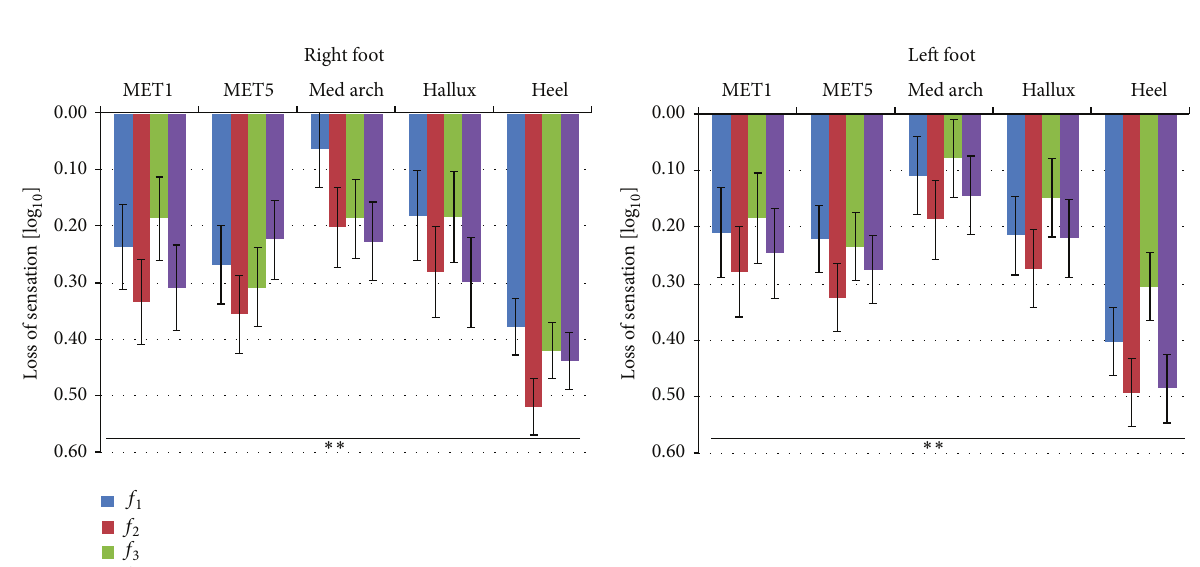
Figure 2: Loss of sensation (LOS) and standard error ( ± SE) in touch-pressure sensitivity with respect to the control condition, for both feet, five regions (heel, medial arch, 5th metatarsal head, 1st metatarsal head, and hallux). All 24 subjects were measured 10 minutes after WBV exposure, at 4 different frequencies of WBV ( 𝑓 1 = 31 , 𝑓 2 = 35 , 𝑓 3 = 40 , and 𝑓 4 = 44 Hz) ( ∗∗ 𝑃 < 0.01 ).